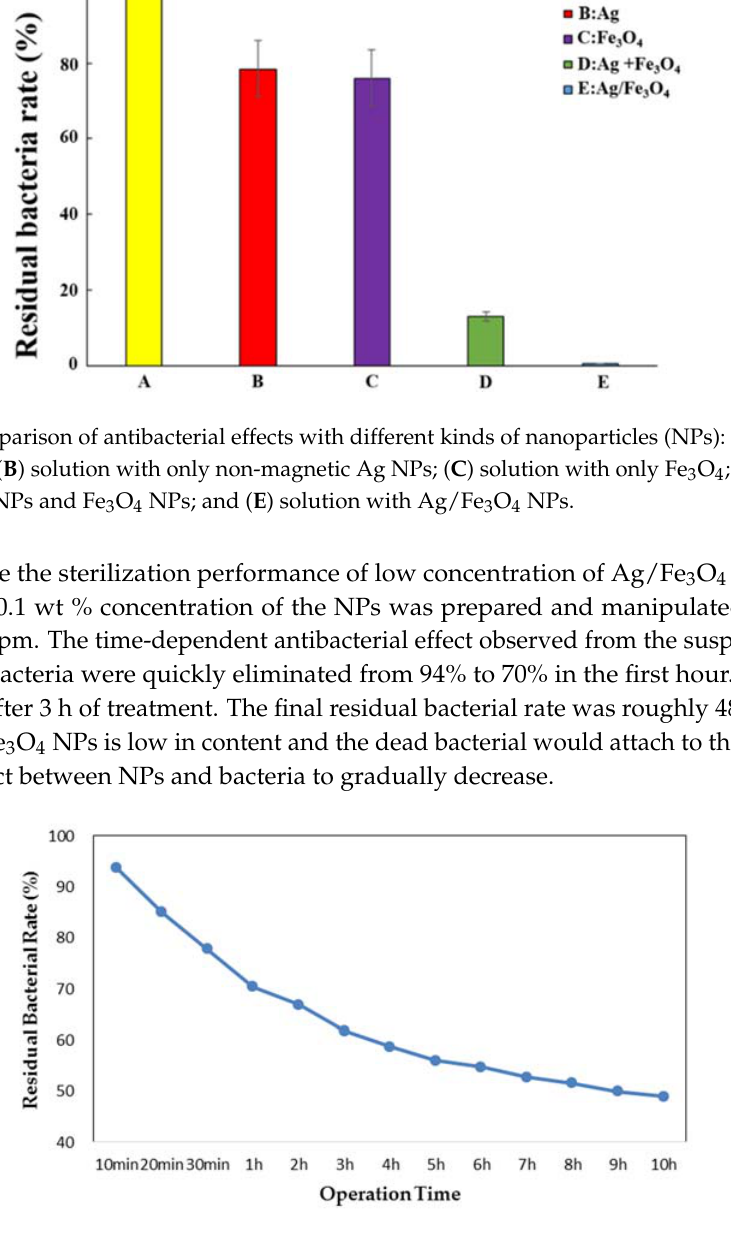
Figure 7. Antibacterial effect to Escherichia coli from 0.1 wt % of Ag/Fe 3 O 4 with driving frequency of 100 rpm.